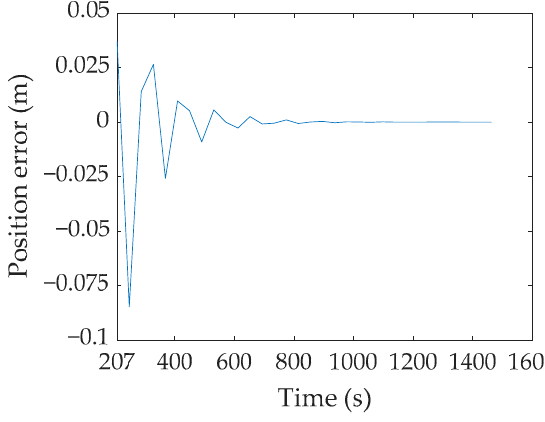
Figure 9. Cross-track position error for the straight line.